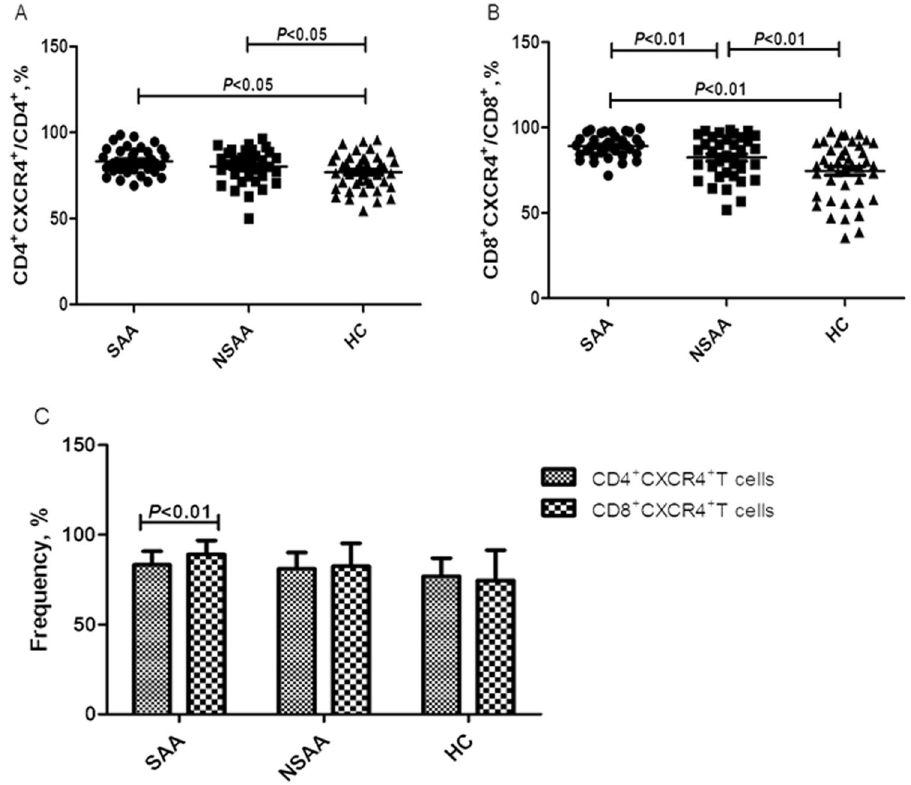
Figure 4. Frequencies of circulating CXCR4 + T-cell subsets in patients with aplastic anaemia and the healthy controls. SAA: severe aplastic anaemia; NSAA: non-severe aplastic anaemia; HC: healthy control. ( A ) Frequencies of CD4 + CXCR4 + T-cells (gating on CD4 + T-cells) in patients with SAA ( • ), patients with NSAA ( ■ ), and the HC ( ▲ ). ( B ) Frequencies of CD8 + CXCR4 + T-cells (gating on CD8 + T-cells) in patients with SAA ( • ), patients with NSAA ( ■ ), and the HC ( ▲ ). ( C ) Intra-group comparisons of the frequencies of CD4 + CXCR4 + T-cells and CD8 + CXCR4 + T-cells.